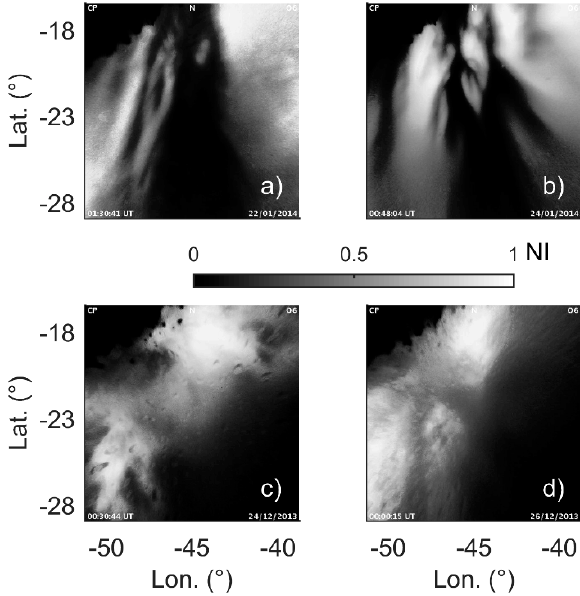
Figure 7. Four cases to build the confusion matrix using the airglow observations in CHPI.